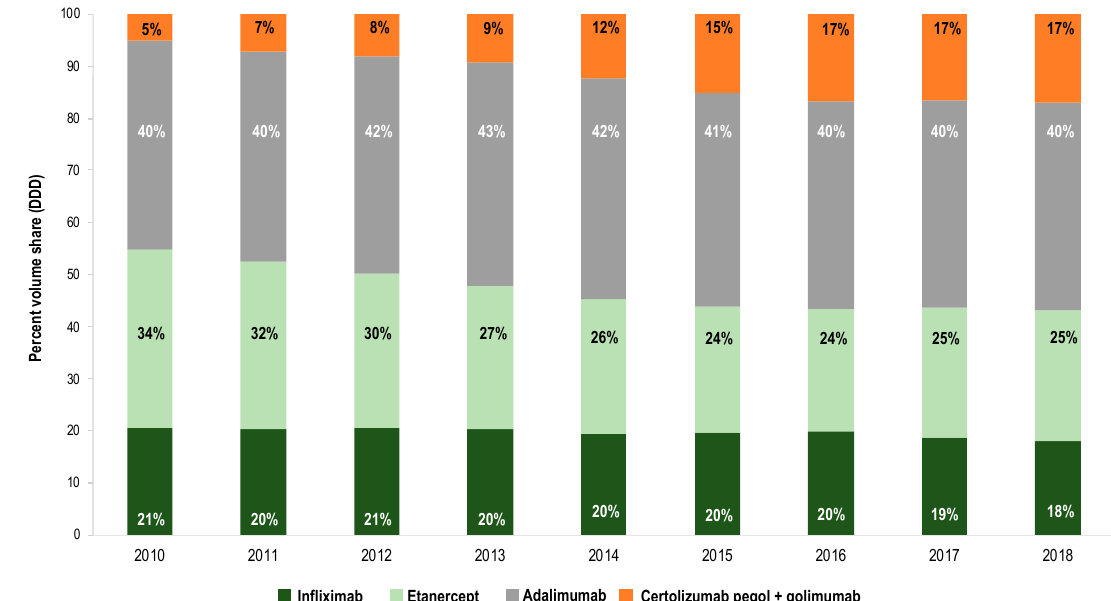
Figure 2. Composition of the market for TNF α inhibitors in terms of individual products from 2010 to 2018. The sales volume (DDDs) for infliximab (originator + biosimilars), etanercept (originator + biosimilars), adalimumab (originator + biosimilars), certolizumab pegol and golimumab is expressed as a share of the total volume of TNF α inhibitors.